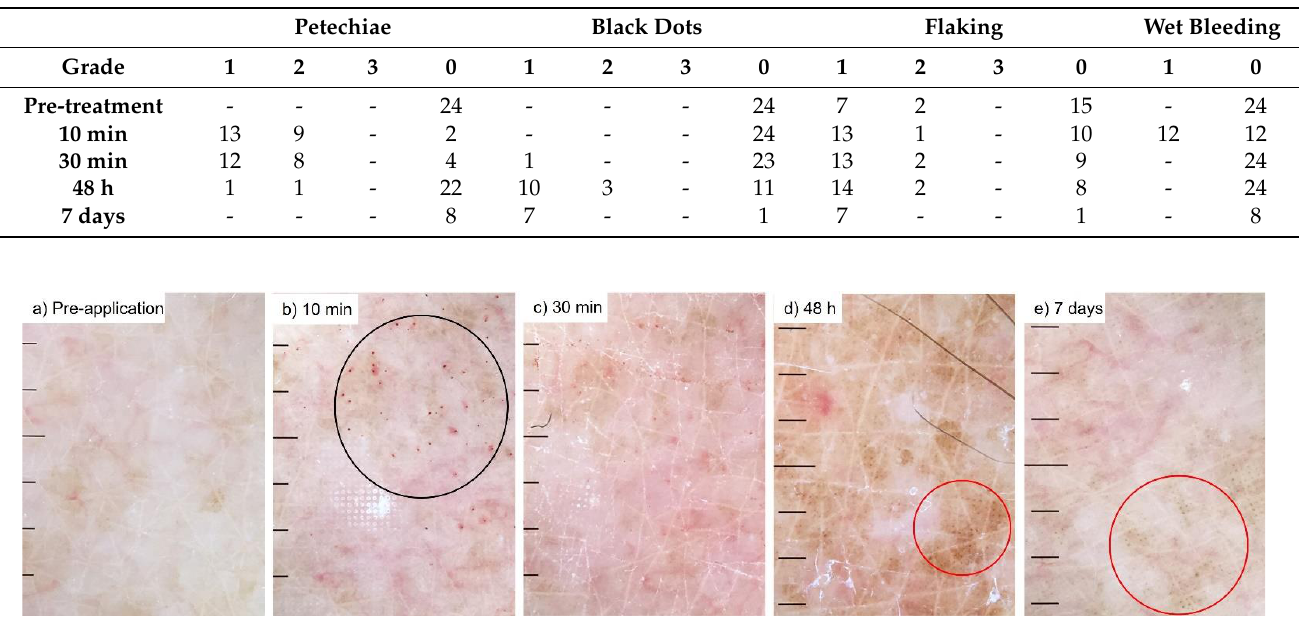
Figure 2. Typical dermatoscopic images from each time point (( a ) pre-application, ( b ) 10 min after application of HD-MAP, ( c ) after 30 min, ( d ) 48 h and ( e ) 7 days). Note that petechiae are prominent after 10 and 30 min, and black dots are observed after 48 h and 7 days. The black circle displays areas with petechiae. Red circles display areas with black dots.